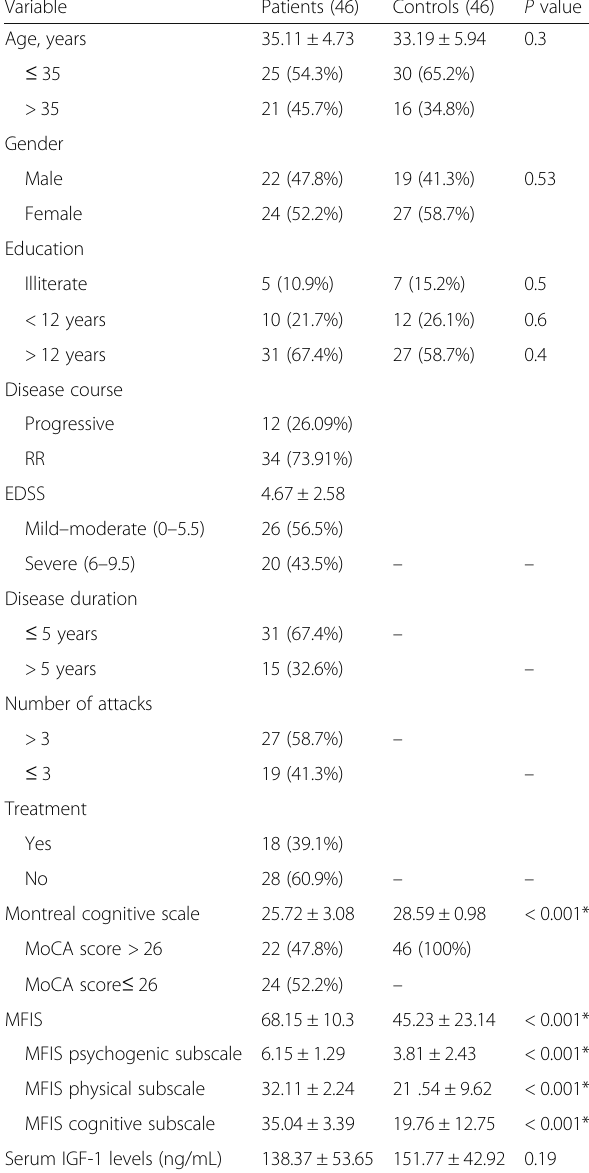
Table 1 Demographic data, clinical characteristics, and scales as well as serum IGF-1 levels of the studied